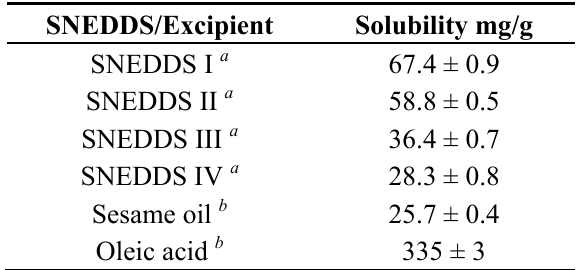
Table 5. Cinnarizine solubility in different